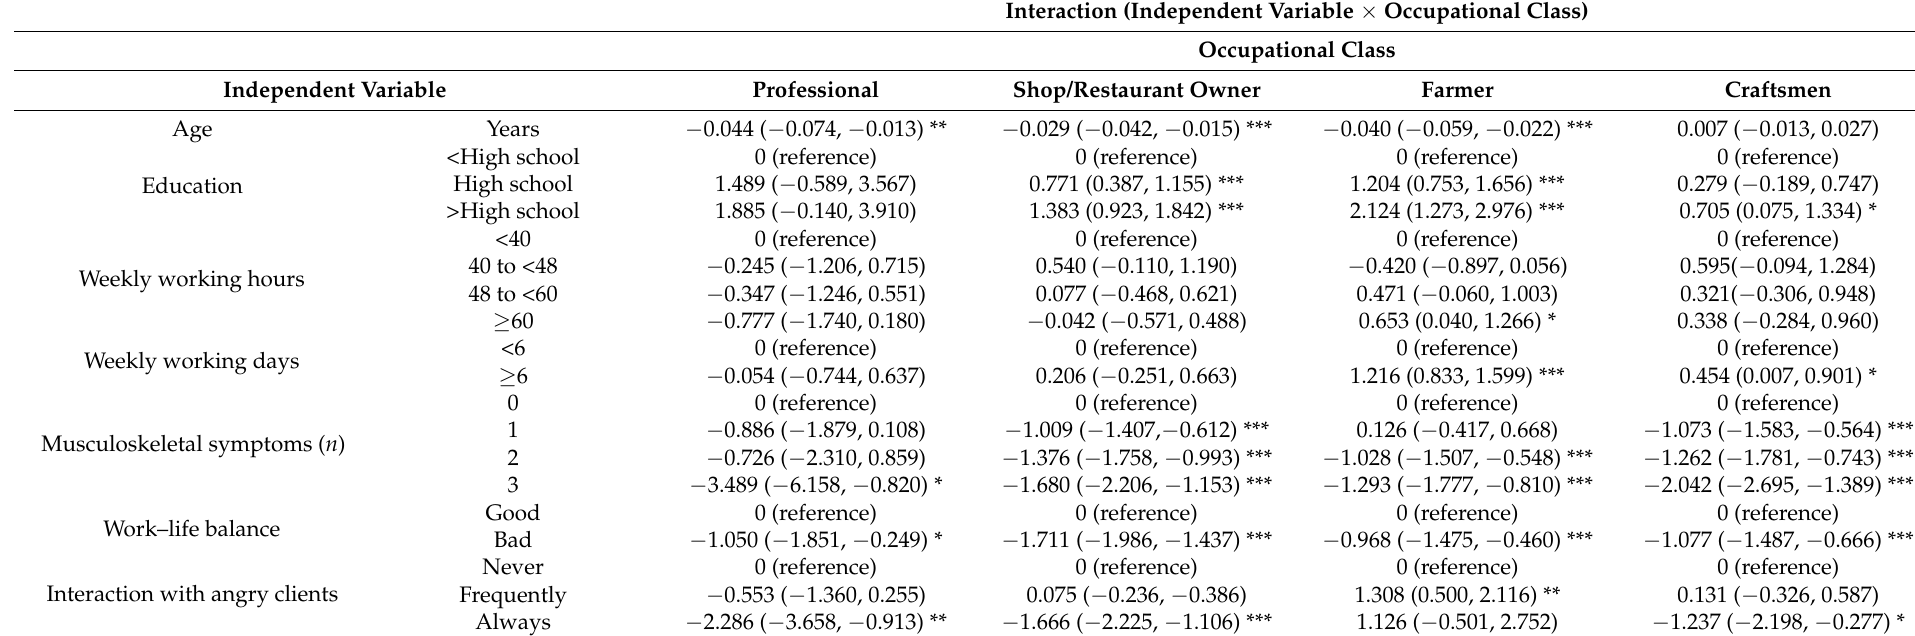
Table 4. Conditional effect (B coefficients [95% CI]) of independent variables on psychological well-being for each occupational class after adjustment for age,